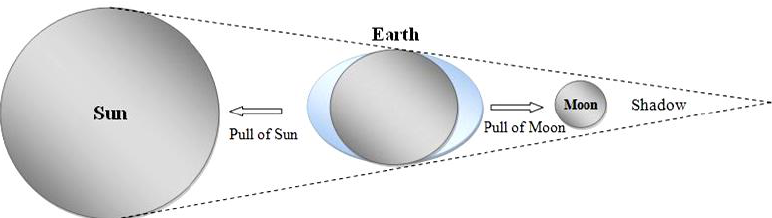
Figure 2. Illustrating the position of the moon (total lunar eclipse).